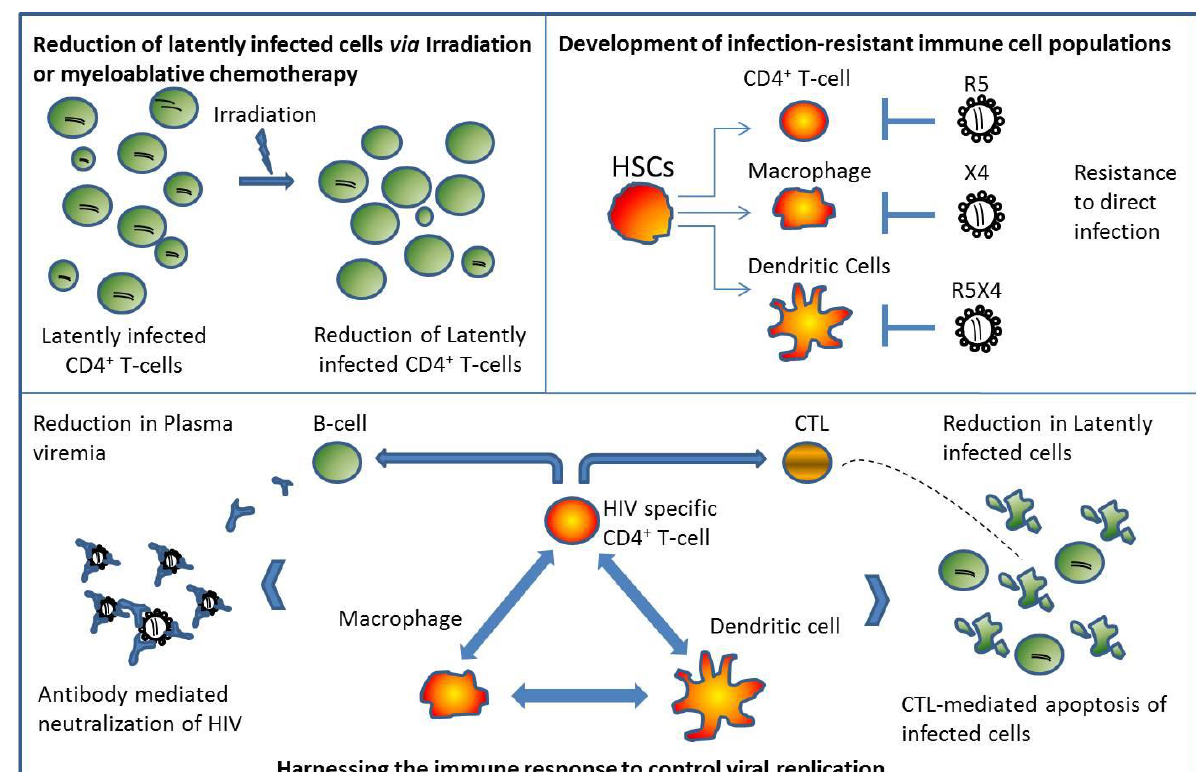
Figure 2. Autologous Transplantation: Developing an Infection-Resistant Immune System Capable of Controlling Viral Replication. (Top Left Panel) Decrease in latently infected cells following total body irradiation or myeloablative chemotherapy. Studies have shown that although there is a significant reduction in proviral DNA in peripheral blood in HIV-1 infected patients undergoing autologous transplantation while on continuous Highly-Active-Anti-Retroviral Therapy (HAART), HIV remains detectable in the months following hematopoietic stem cell transplantation (HSCT). (Top Right Panel) Genetically modified HSCs give rise to infection-resistant immune cells following successful engraftment. Depending on the method used to render immune cells resistant to infection, genetically modified cells can block HIV-infection regardless of viral tropism. (Bottom Panel) Protected immune cells provide the necessary means to effectively control viral replication in the absence of HAART. CTL and B-cell function are enhanced due to CD4+ T-cell helper function resulting in increased CTL-mediated apoptosis of infected cells and improved neutralization of plasma viremia. Overall immune function is restored and maintained following the cessation of